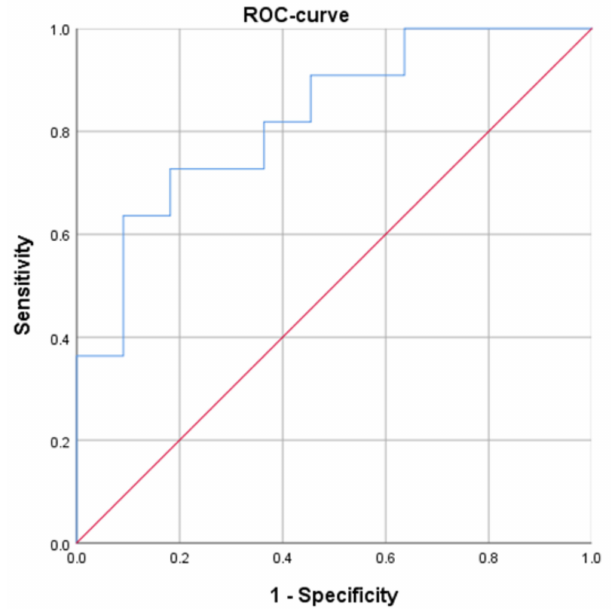
Figure 2. The receiver operating characteristic (ROC) curve using SUV max for distinguishing tumors with high microvessel density from lesions with low microvascularization. The optimal threshold SUV max is 15, resulting in a sensitivity of 70.0% and a specificity of 75.0%. The area under the curve is